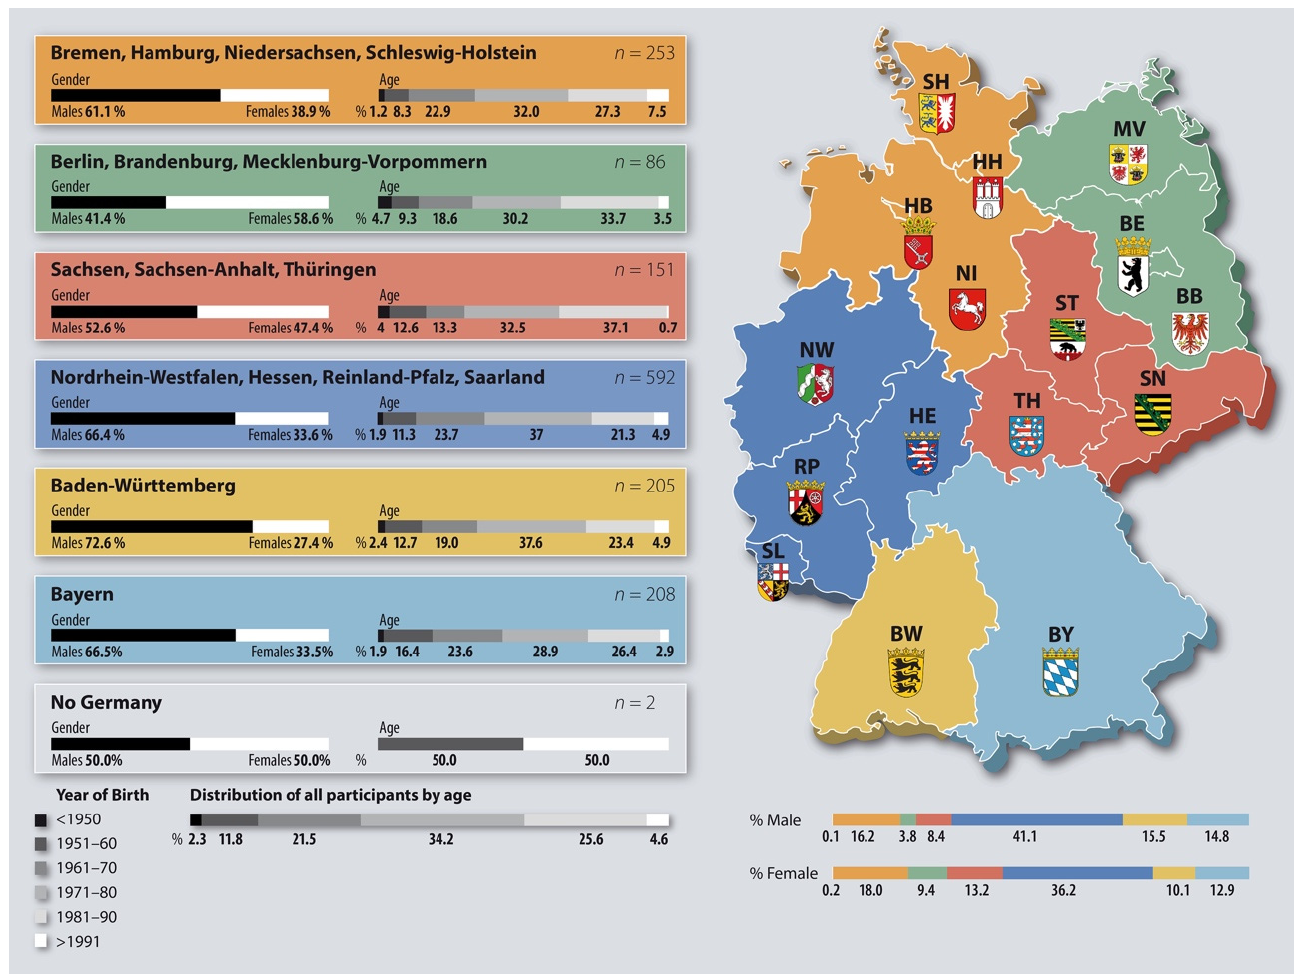
Figure 1. Distribution of sex, age and provenance of the participants. Table 1. Distribution of the